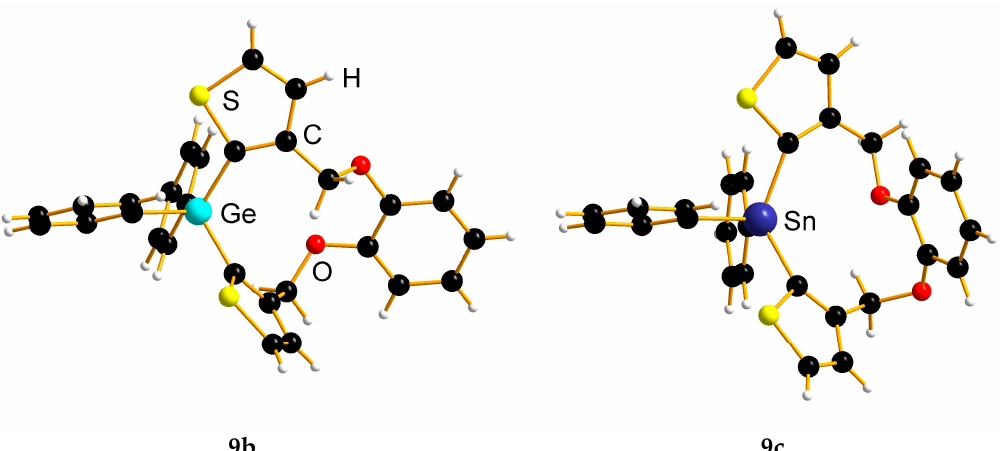
Figure 2. Molecular structures of compounds 9b and 9c . In 9b , the CH 2 group on C-18 is twisted inwards of the concave side of the molecule, whereas in 9c , the overall larger ring size forces it to twist outwards, and thus opening up the cavity. Table 1. Selected interatomic distances and angles of 9b and 9c, and torsion angles.